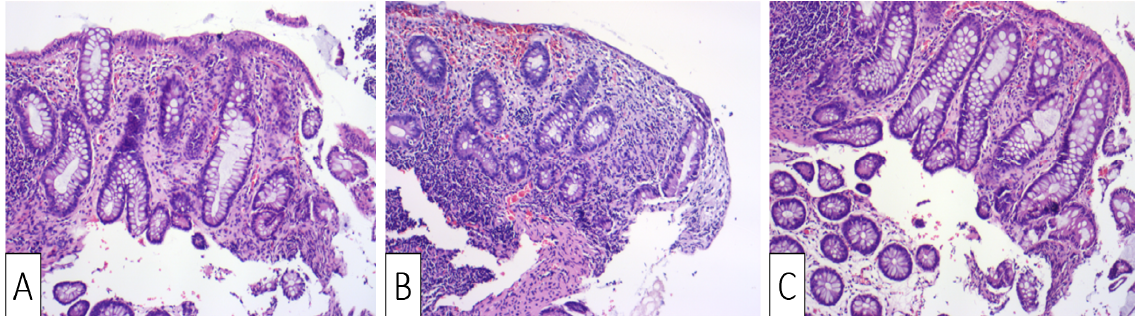
Figure 4. H&E ×10 Sigmoid mucosa at follow-up following treatment: ( A ) Sigmoid mucosa showing mild distortion of crypts and lamina propria densification.; ( B ) sigmoid mucosa showing distortion of crypts and lamina propria densification; ( C ) sigmoid mucosa showing lamina propria densification (top right) compared to normal stroma (bottom left).